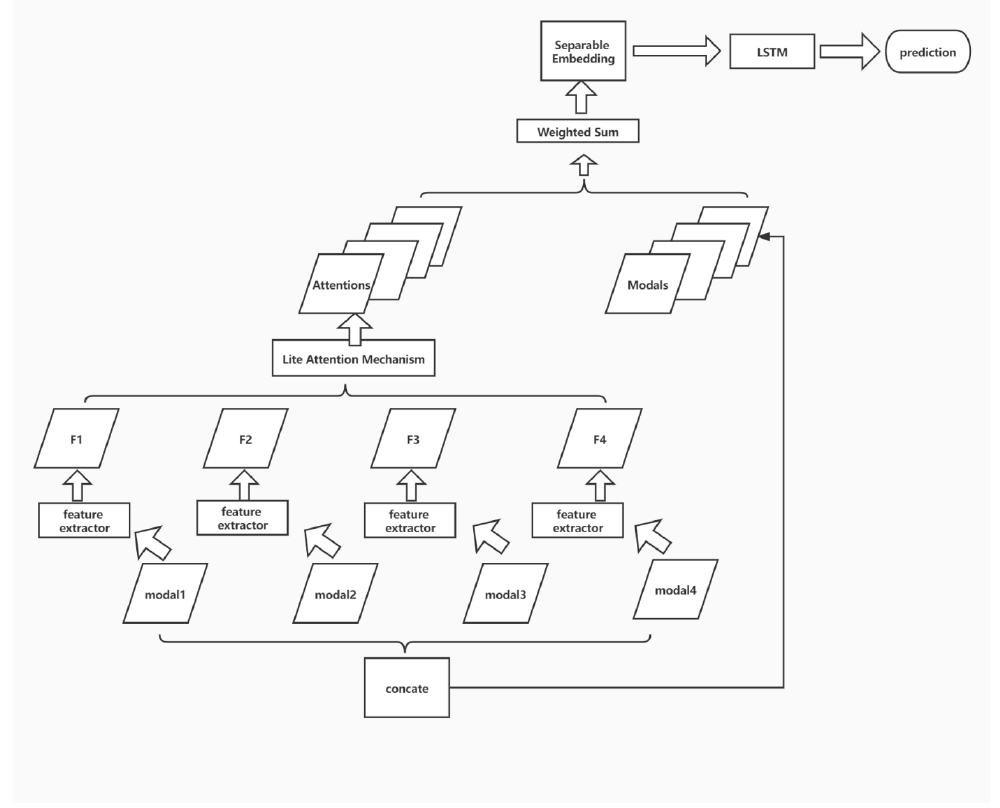
Figure 4. The learning